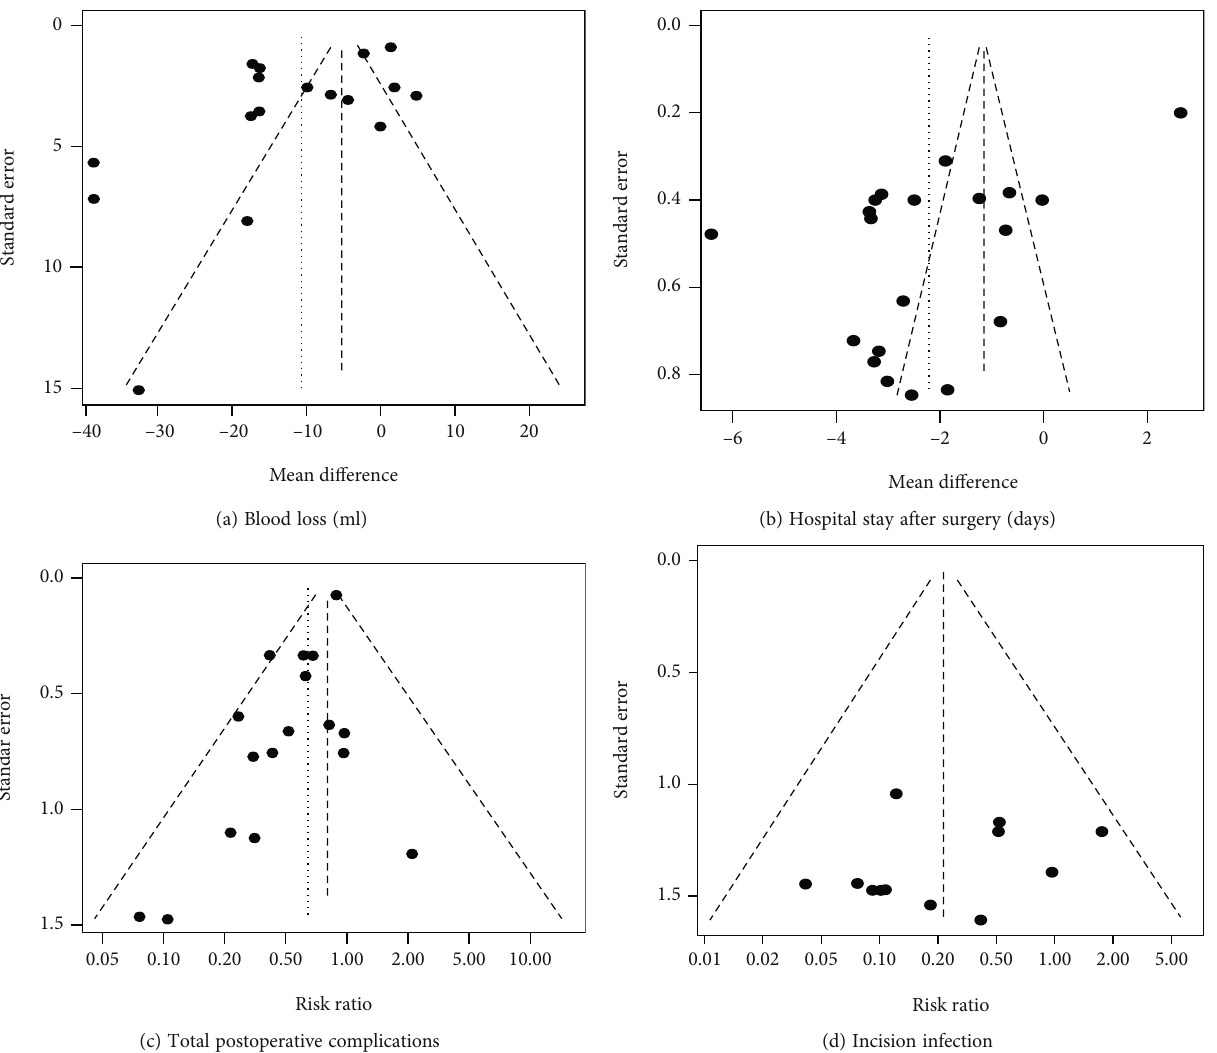
Figure 2: Funnel plot of the meta-analysis using the rate ratios against their standard errors. (a) Estimated blood loss in millilitres; (b) hospital stay after surgery in days; (c) total postoperative complications; (d) incision